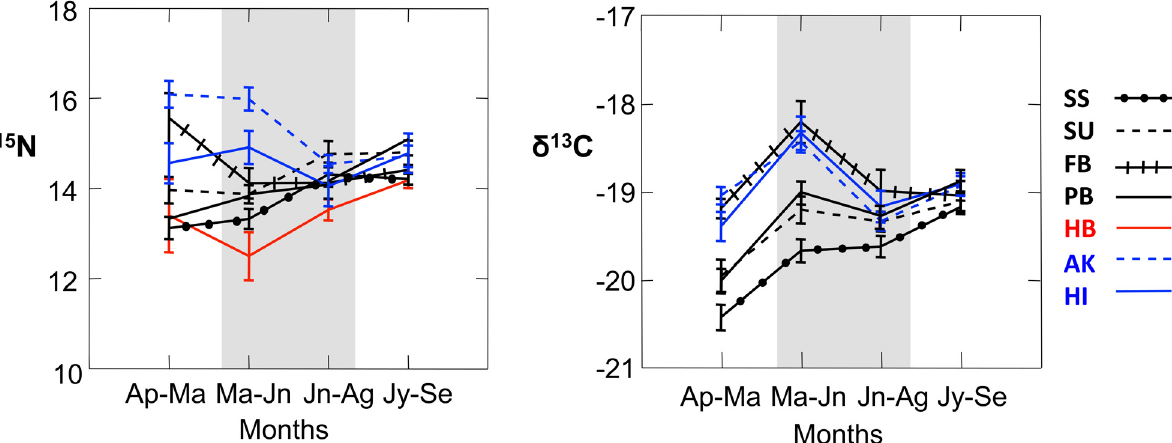
Fig 1. Nitrogen and carbon stable isotope values (mean ± SE) from Laysan albatross foraging over four consecutive time periods as a function of sampling category. SS = sequentially successful breeders (fledged a chick in 2006 and 2007; feather samples from 2006); SU = sequentially unsuccessful breeders (fledged a chick in 2006, failed during incubation in 2007; feather samples from 2006); FB: failed breeders (failed during incubation in 2006, laid an egg in 2007; feather samples from 2006); PB: prebreeders (courting on Midway in January, 2007, feather samples from 2006), HB: historic birds, HI: Hawaiian fisheries-bycaught birds, and AK: Alaskan fisheries-bycaught birds. Data from sampling periods shaded in gray were not tested statistically because the breeding status of birds during these periods was uncertain due to variability of molt initiation dates.